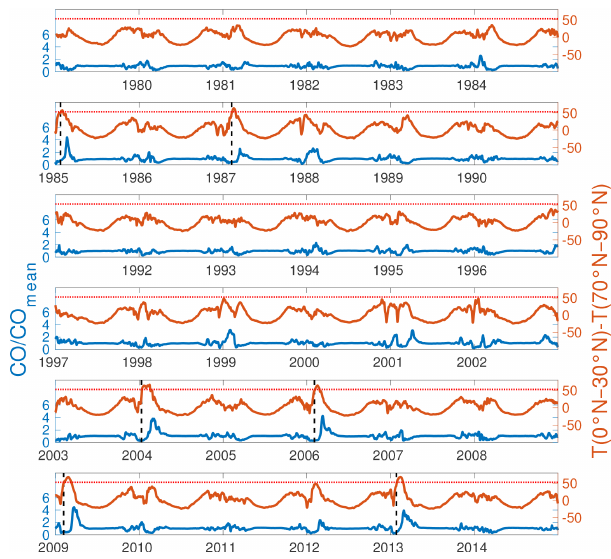
Figure 9. Temporal evolution of (cid:49)T 30–70 (in K) = T (0– 30 ◦ N) − T (70–90 ◦ N) at 1hPa (solid red) and 70–90 ◦ N zonal mean CO anomalies (with respect to the climatological seasonal mean, in ppmv) at 0.5hPa (solid blue). The threshold of (cid:49)T 30–70 = 53K for ES detection is indicated by the dotted red line. Detected event onsets are marked by vertical dashed lines.